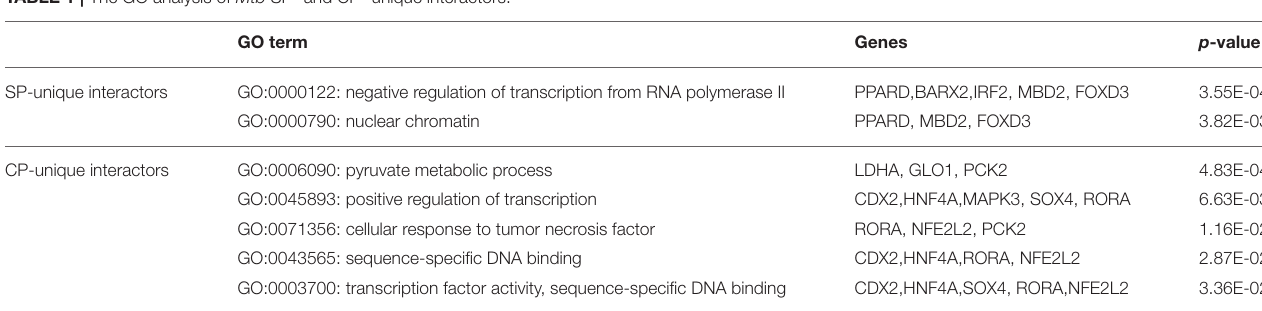
TABLE 1 | The GO analysis of Mtb SP- and CP- unique